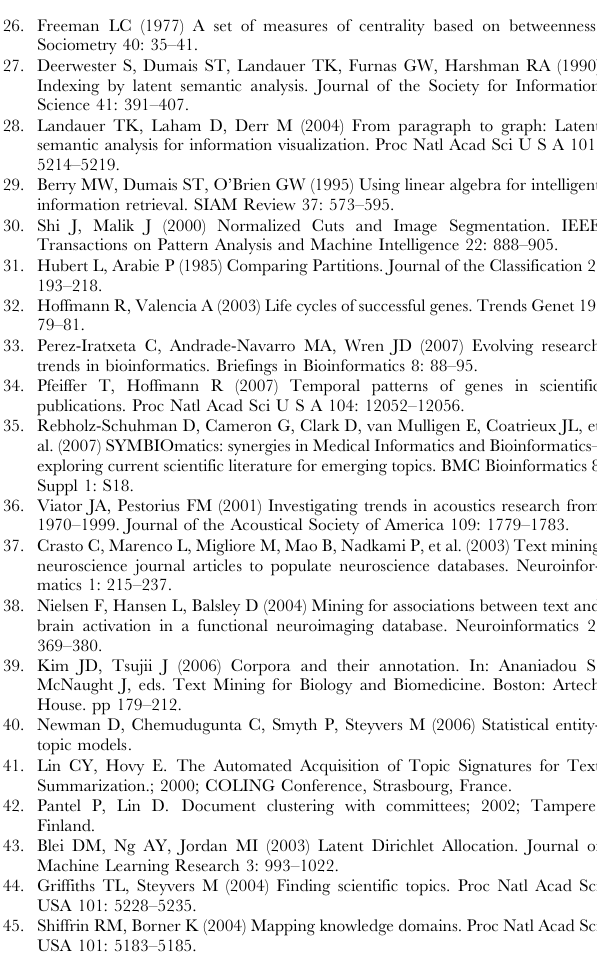
Table S1 Top 20 most frequently used words in each NCuts topic cluster. The words in each topic cluster are sorted in descending order of frequencies of usage, which are denoted in parenthesis. The size (or number of abstracts) of each cluster is also denoted in parenthesis.